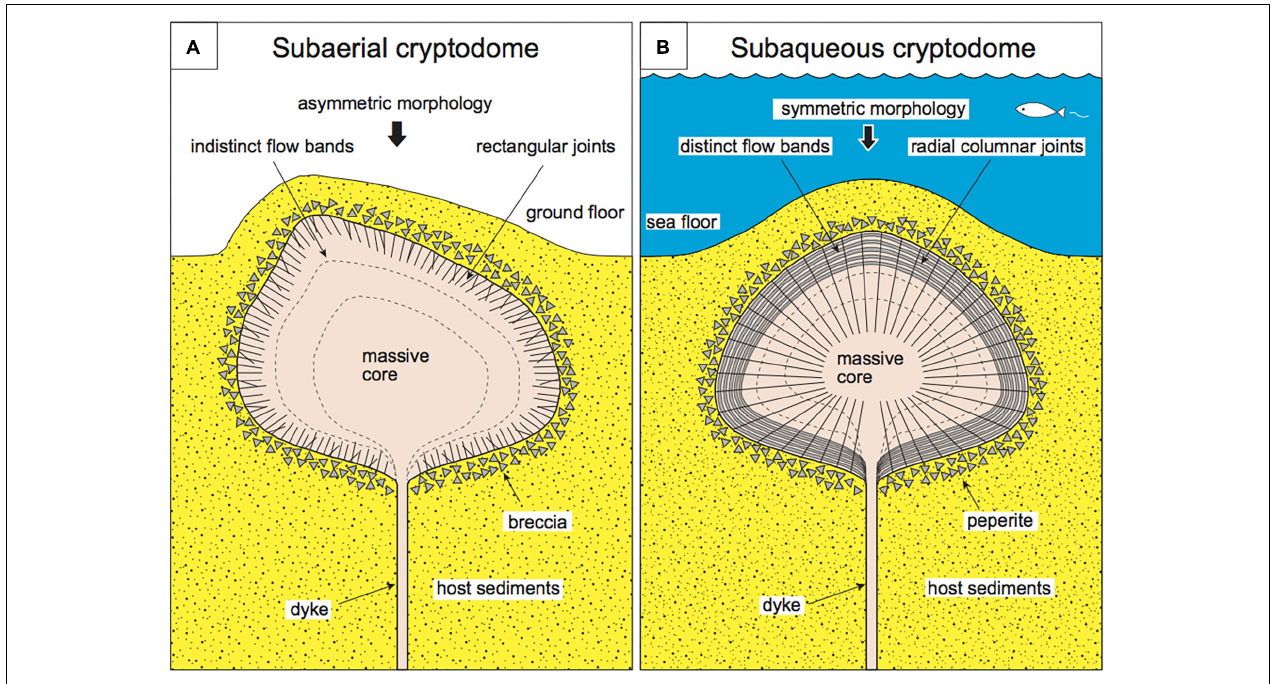
FIGURE 12 | Comparison between (A) a subaerial cryptodome and (B) a subaqueous cryptodome. The morphology and internal structures of the subaerial cryptodome differ from those of the subaqueous cryptodome. The subaerial cryptodome is characterized by an asymmetrical (anisotropic) morphology, distinct rectangular joints, and indistinct large-scale flow banding. The subaqueous cryptodome is characterized by a symmetrical morphology, well-developed radial columnar joints, and distinct large-scale flow banding. Peperite is only found in subaqueous